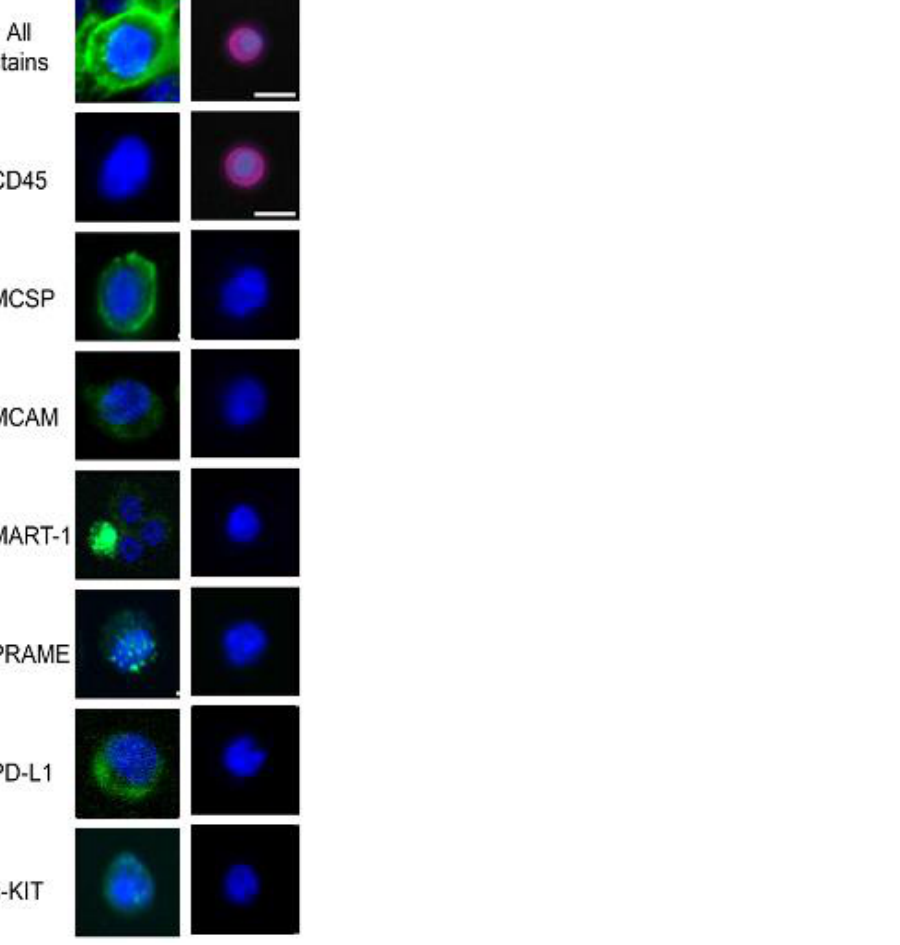
Figure 2. Direct Immunofluorescence Live Cell Staining Cocktail Validation. A375 and peripheral blood mononuclear cells (PBMCs) were stained with 1 µ L of each antibody to validate that the FITC-conjugated (green) melanocyte-specific markers stain melanoma cells but do not cross react with PBMCs, and ensure that APC-conjugated CD45 (red) does not cross react with melanoma cells. Some markers stained faintly and/or only on a subset of cells in the population, but were included in the final cocktail to enrich patient-derived CTCs with expression patterns that differ from these cell lines. Scale bars are 10 µ